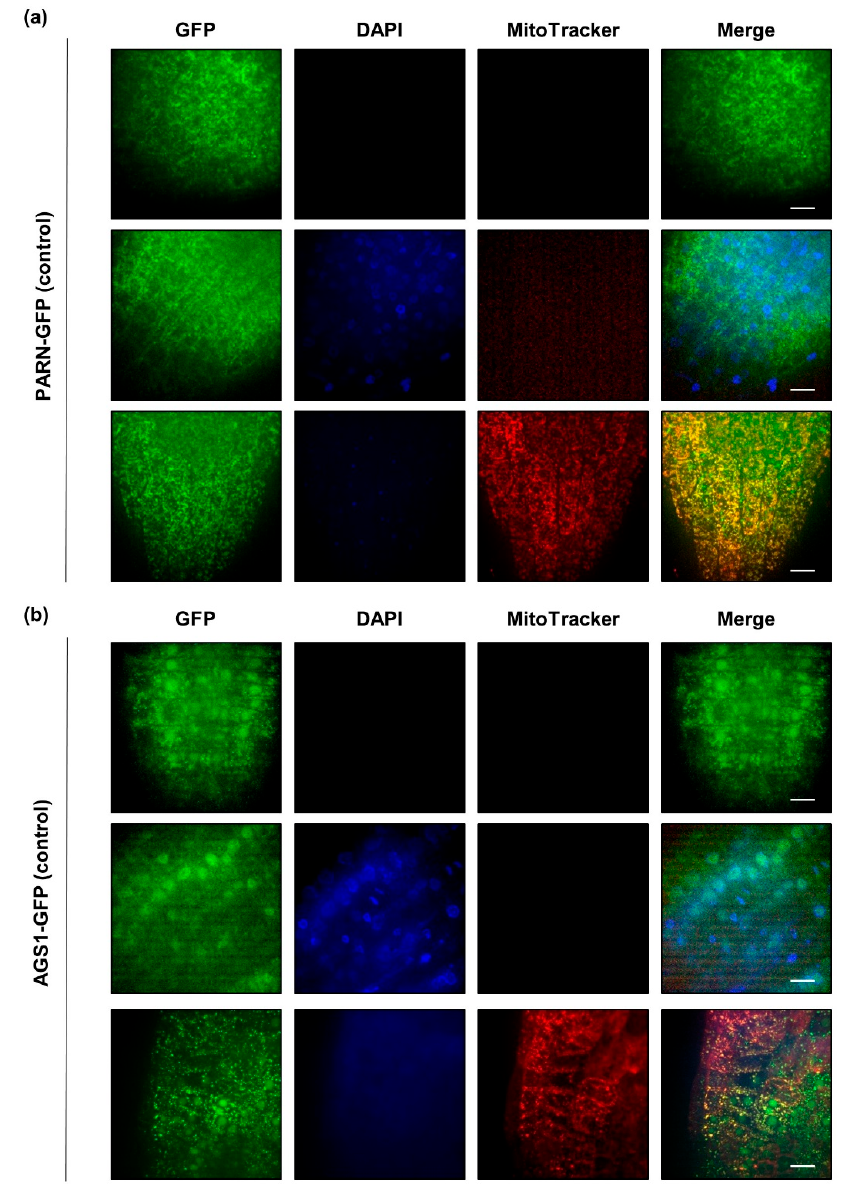
Figure 3. Under full nutrient supply, PARN-GFP (a) localizes to cytoplasmic speckles, whereas AGS1-GFP (b) is confined to the nucleus. Roots (tip and elongation zones) of ten-day-old PARN-GFP and AGS1-GFP seedlings grown under control conditions were left untreated (first row) or incubated with DAPI (second row) and MitoTracker Orange (third row). Each column represents a different channel (GFP, DAPI, MitoTracker). The last column shows a merge of all channels. Pictures are the result of maximum intensity z-projections of slices in a z-stack. Scale bar 10 µm.